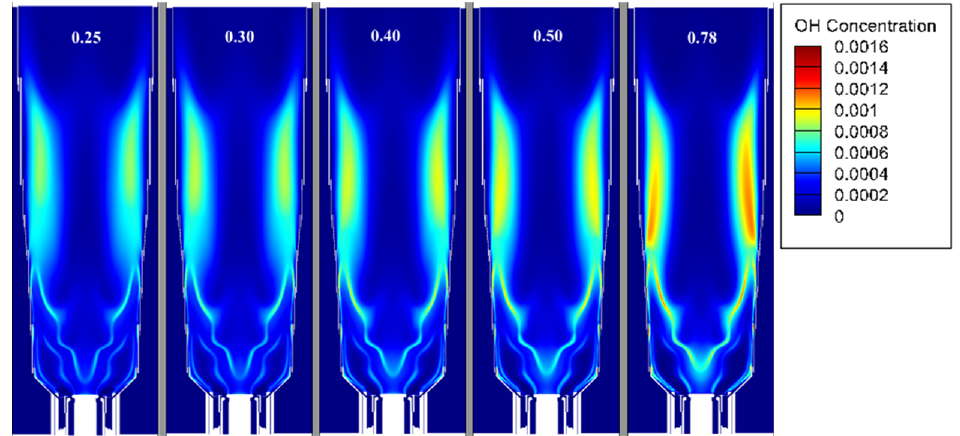
Figure 6. Sensitivity study over the turbulent Schmidt number—base load.